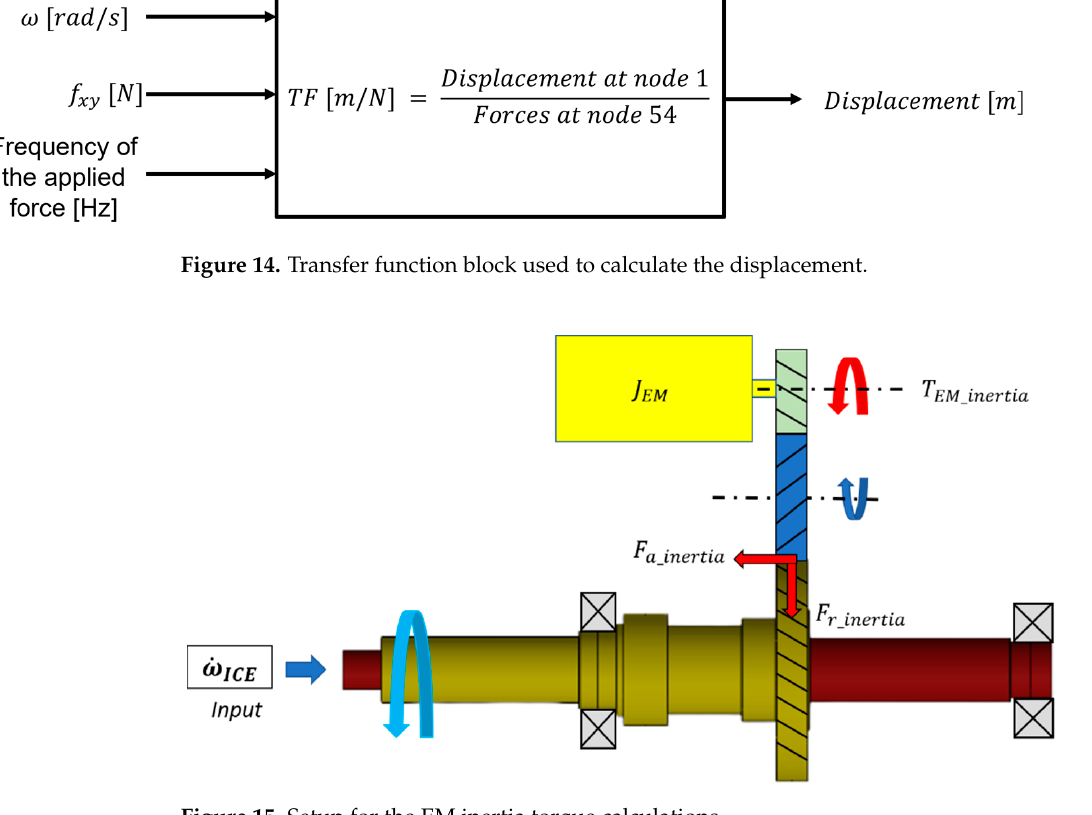
Figure 15. Setup for the EM inertia torque calculations.